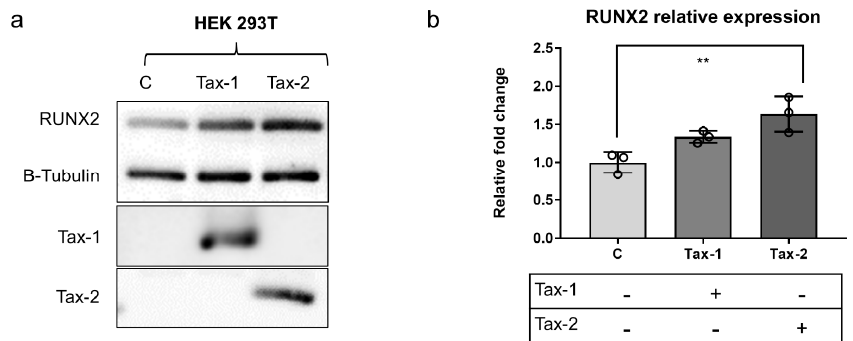
Figure 4. On the left ( a ), representative Western blot analysis of the HEK293T control cells and cells transfected with Tax-1 pJFE or Tax-2 pJFE showing an increase in RUNX2 protein expression in cells transfected with the HTLV-2 Tax protein. On the right ( b ), histogram bars represent the densitometric analysis of the Western blot bands corresponding to RUNX2 normalized to tubulin. ** = p value < 0.01 using one-way ANOVA; c = control non-transfected cells; Tax-1 = cells transfected with Tax-1 pJFE; Tax-2 = cells transfected with Tax-2 pJFE.